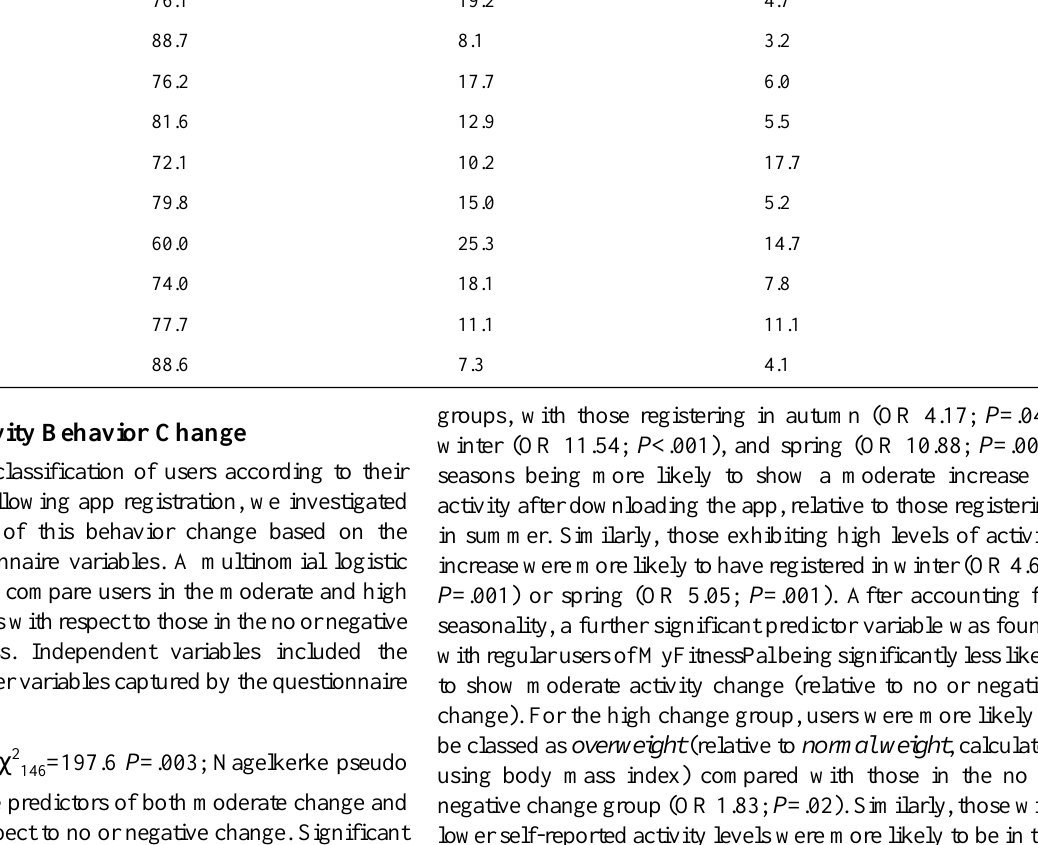
Regularly use, %Sometimes use, %Never use, %App